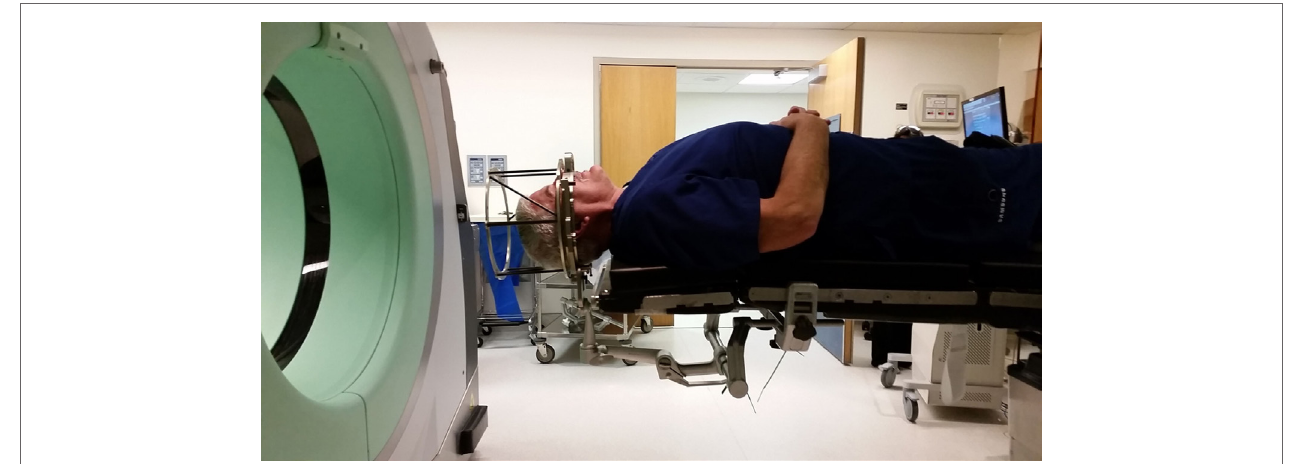
FIGURe 2 | positioning of potential patient in CRW frame, prior to Ct scanning